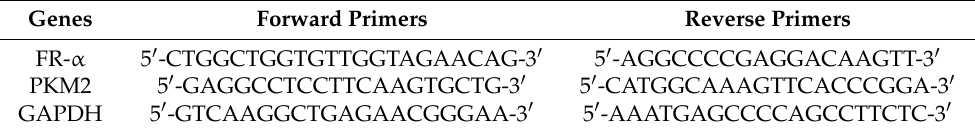
Table 1. The primers’ sequence for quantitative real-time PCR.